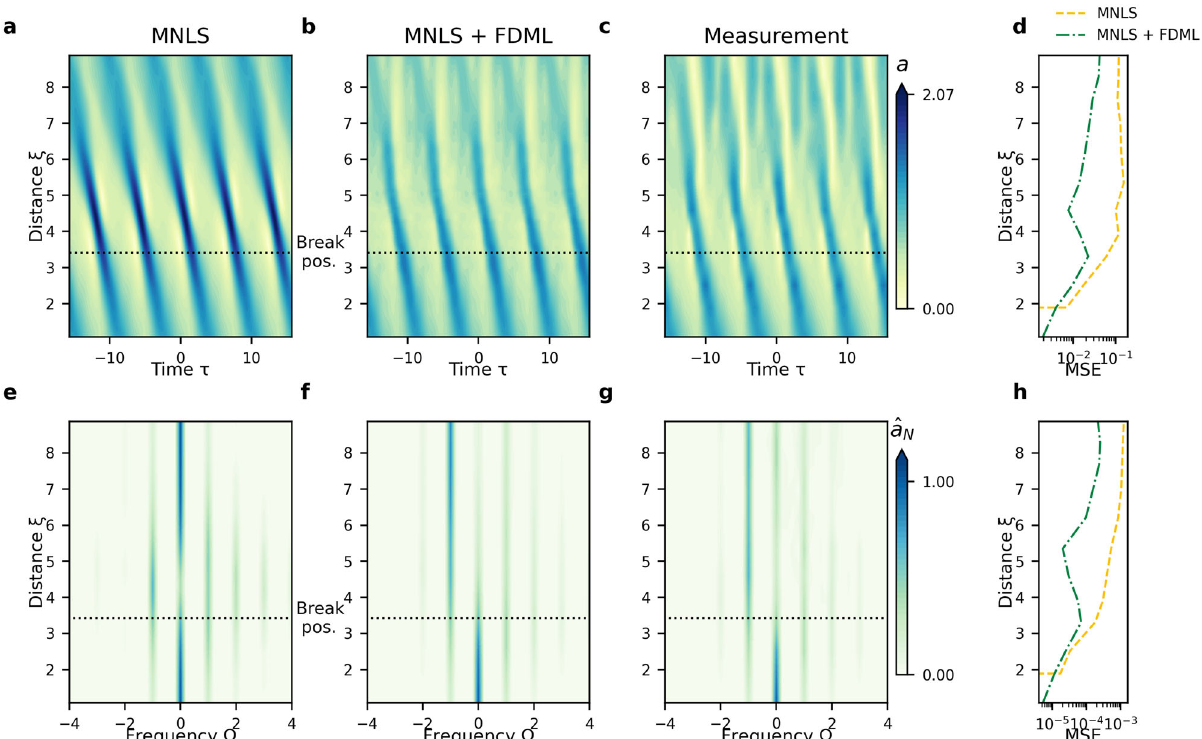
Fig. 1 Example result (not used for training) for the spatial evolution of a modulated plane wave (Wave Category I) showing wave breaking at ξ = 3.42, as indicated by the black dotted line. a – d Time domain. Color bar indicates surface envelope amplitude a (see eq. (1)). a MNLS simulations. b MNLS + FDML simulations. c Measurements. d Mean squared error (MSE) at each wave gauge between measurements and MNLS or MNLS + FDML simulations. e – h Frequency domain, similar panel con fi guration as in the time domain, with the color bar indicating the magnitude of the amplitude spectrum normalized by the maximum of the initial condition ( ^ a N